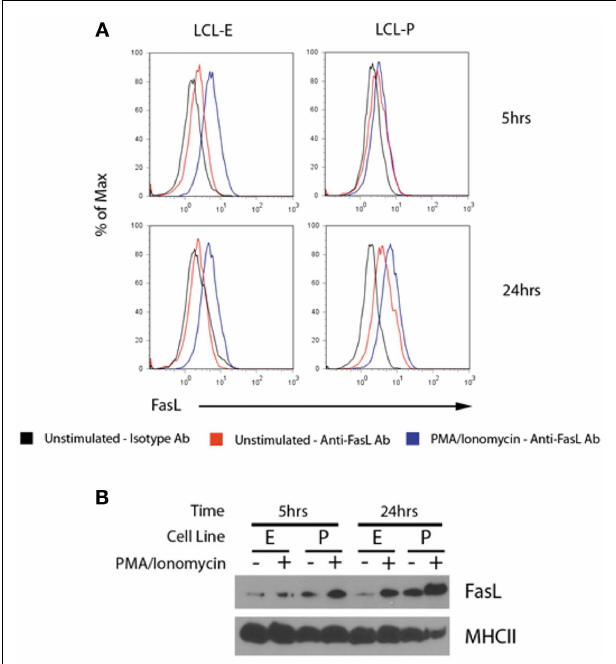
FIGURE 4 | LCL secrete MHCII + FasL + exosomes. (A) Two LCL (designated “LCL-E” and “LCL-P”) were placed into fresh exosome-free media in the presence or absence of PMA/ionomycin. After 5h (top panels) or 24h (bottom panels), exosomes were isolated from culture supernatants as described in the section “Materials and Methods.” Purified exosomes were then incubated with anti-HLA-DR-coated beads as described in Figure 3 . Beads were washed and stained with either anti-FasL or an isotype control antibody. Beads were coated with an appropriate isotype control antibody as the capture antibody did not display any FasL staining (data not shown). (B) Cells from above experiment were harvested, lysed, and probed for FasL and MHCII (HLA-DR) by